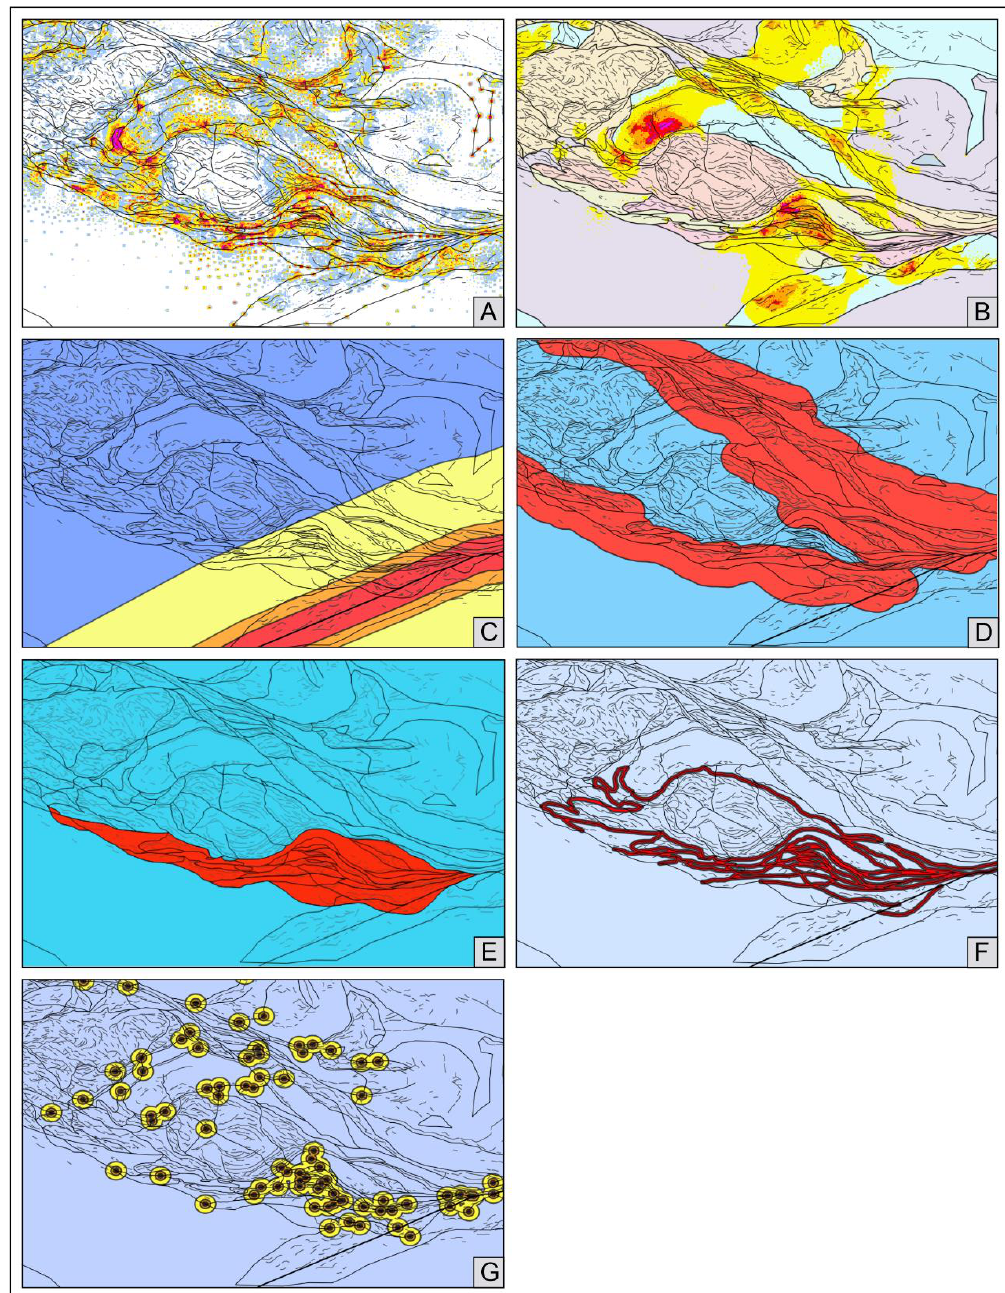
Figure 11. Input layers for the target index: ( A ) spatial changes in differential stress during the simulated stress regime; ( B ) high concentrations of shear strain during the simulated stress regime; ( C ) three buffer zones with weighting according to their proximity to the major ENE-trending Karari and Bulgunnia Shear/Fault Zones; ( D ) a buffer surrounding the interpreted Skylark Shear Zone and Southern Overthrust that represent probable extensions of Olympic Dam-trending deep-seated 1st-order structures (viz., the displaced Elizabeth Creek Fault Zone trend); ( E ) tectonostratigraphic host package of IOCG mineralisation in the Prominent Hill area; ( F ) contacts between significantly contrasting rock competencies, for example between the components of the host units around the Prominent Hill deposit and at the contact of the gabbro/gabbrodiorite body with surrounding tectonostratigraphy; and ( G ) Point/Ring buffers surrounding the obtuse intersection angle between structures, foliations or structure–foliation interactions (as per Figure